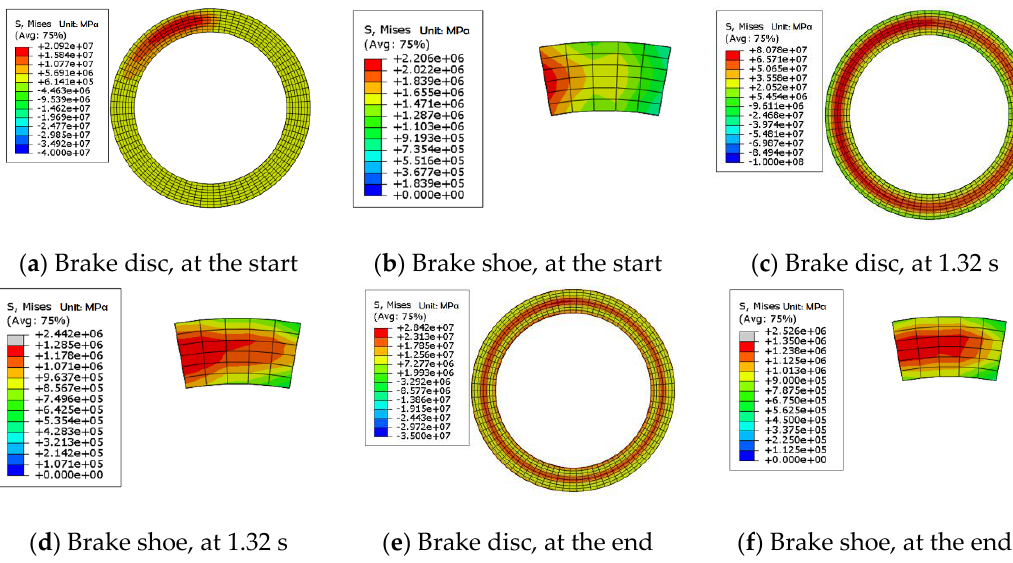
Figure 5. Equivalent stress distributions at contact surfaces of brake disc and brake shoe during emergency braking.